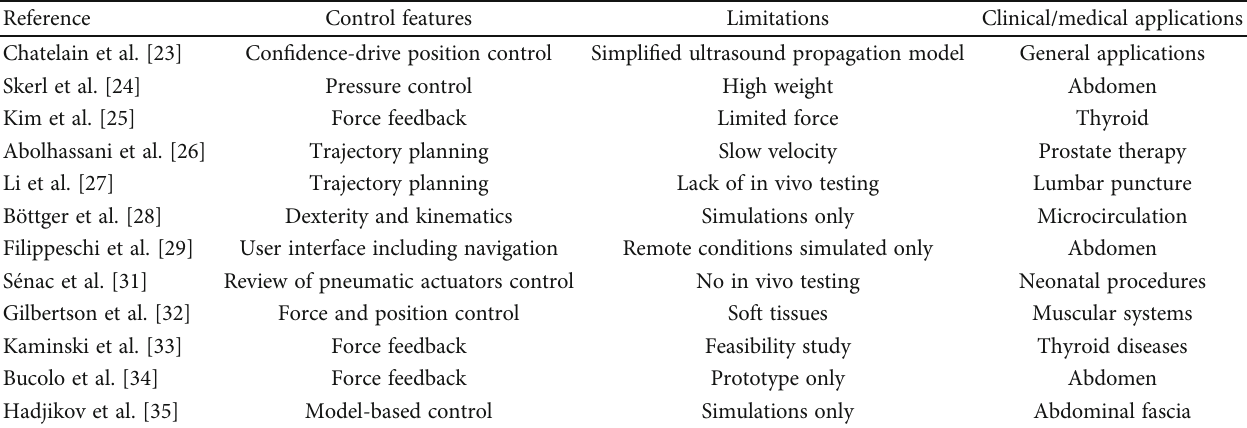
Table 2: Comparison of di ff erent control strategies.